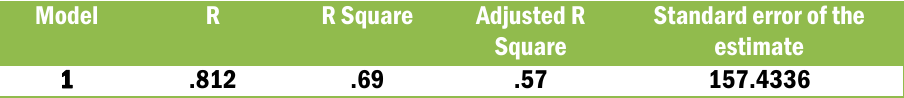
Table 6: Model summary of the simple Regression for Public service ethos Model